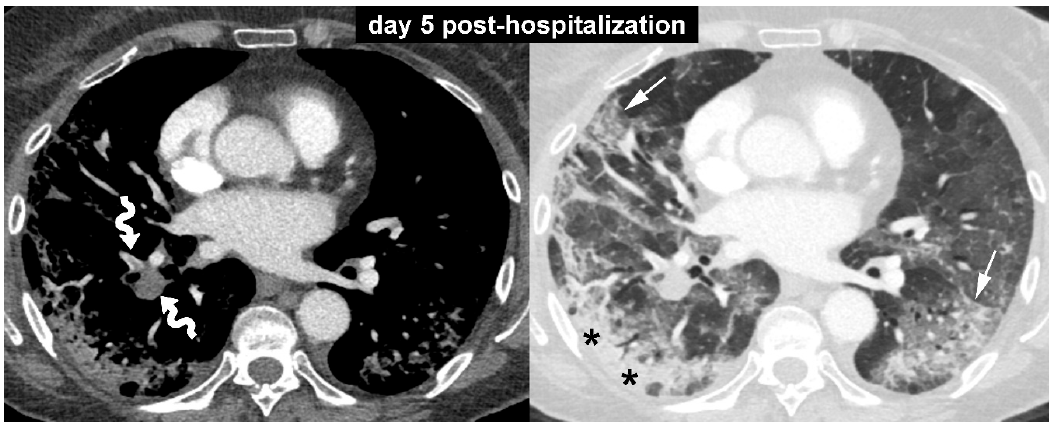
Figure 1. A 73-year-old woman was referred to our emergency department for the evaluation of a 10-day history of fever, dry cough, and shortness of breath. Her medical history was unremarkable except for a previous diagnosis of breast cancer. She had no history of lung comorbidities, such as asthma, chronic obstructive pulmonary disease, or interstitial lung disease. On presentation, the patient exhibited significant breathlessness, and arterial blood gas analysis revealed a pH of 7.51, PCO 2 of 29 mmHg, PO 2 of 43 mmHg, and oxygen saturation of 81%. Based on these data, 15 L/min of oxygen was administered through a non-re-breathing reservoir mask. Chest radiography showed bilateral interstitial and alveolar infiltrates in both lungs, greater on the right side. On the same day, the patient underwent nasopharyngeal swab, which confirmed the clinical suspicion of coronavirus disease (COVID-19). The following day the patient was transferred to an intermediate care unit. During the first few days in the hospital, her oxygen saturation was 90–95% with use of the non-re-breathing oxygen mask. On day five post-hospitalization, the patient experienced a sudden deterioration of lung function. Laboratory parameters also showed a significant increase in D-dimer levels (5250 ng/mL; reference value, less than 232 ng/mL). Based on these data, contrast-enhanced computed tomography (CT) scan was performed. The contrast-enhanced CT images with mediastinal and lung window setting (Figure 1) showed filling defects in some branches of the pulmonary artery (curved arrows) and bilateral ground-glass opacities (arrows) associated with areas of consolidation (asterisks). No evidence of pulmonary fibrosis was found in this initial CT examination.